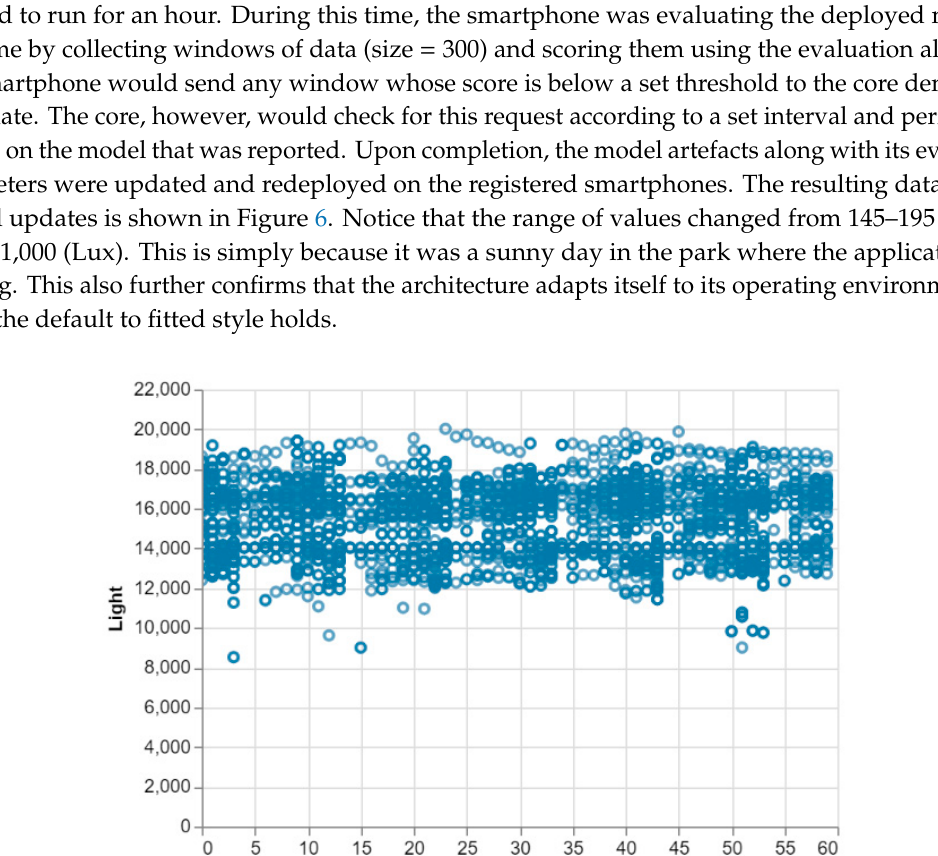
Figure 5. Result of the test dataset for the default model. The x-axis represents the time (sec) while the y-axis is the light intensity in Lux.